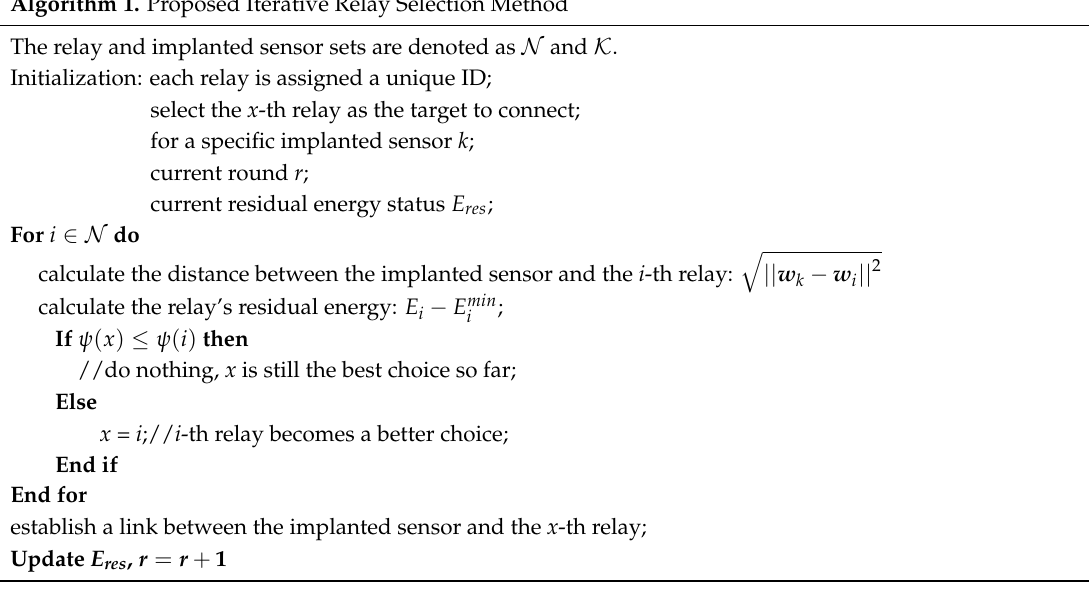
Algorithm 1. Proposed Iterative Relay Selection